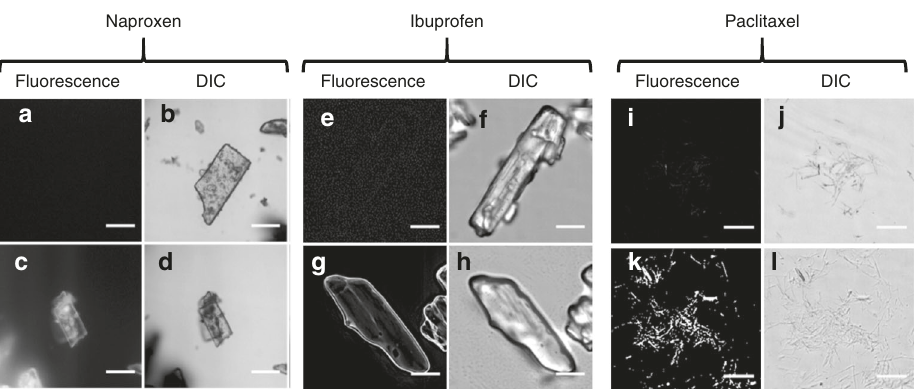
Fig. 5 Fluorescence (shown in white for clarity) and differential interference contrast (DIC) images of drug crystal following treatment with either P 188 (control), or NP1P 188 for 2 h. a , b Naproxen following treatment with P 188 . c , d Naproxen following treatment with NP 1 -P 188 . e , f Ibuprofen following treatment with P 188 . g , h Ibuprofen following treatment with NP1P 188 . i , j Paclitaxel following treatment with P 188 . k , l Paclitaxel following treatment with NP1P 188 . Scale bars 70 μ m. See Supplementary Fig. 6 for alternative views showing images as red fl uorescence overlaid on the